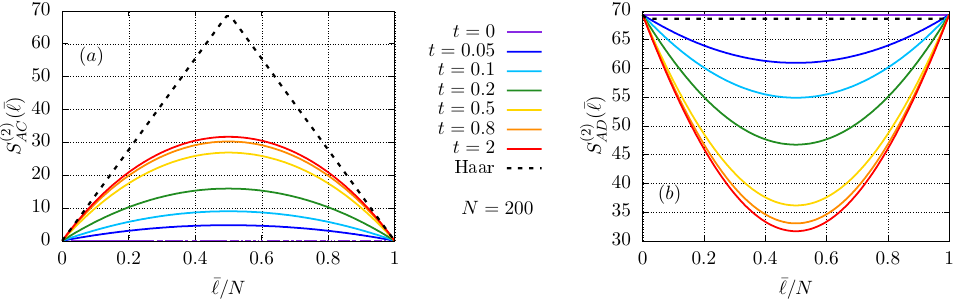
Figure 13 . The entanglement entropies S (2) several times t in the free case. The black dotted lines show the values reached with